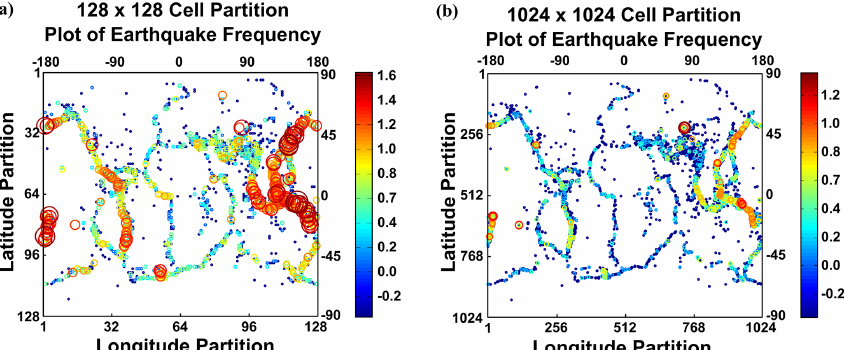
Figure 1. Partitioning of the global seismicity map: (a) 128 × 128 gridding of the latitude–longitude map. (b) 1024 × 1024 gridding of the latitude–longitude map. Earthquakes of magnitudes exceeding or equal to M w = 5.5 and location depth not exceeding 70km for the time period from January 1970 to September 2014 constitute the glacial seismicity map. Earthquake information was downloaded from IRIS (Incorporated Research Institutions for Seismology). The earthquake frequency used in the maps is plotted on a log(log) display scale, with larger circles representing higher frequencies.